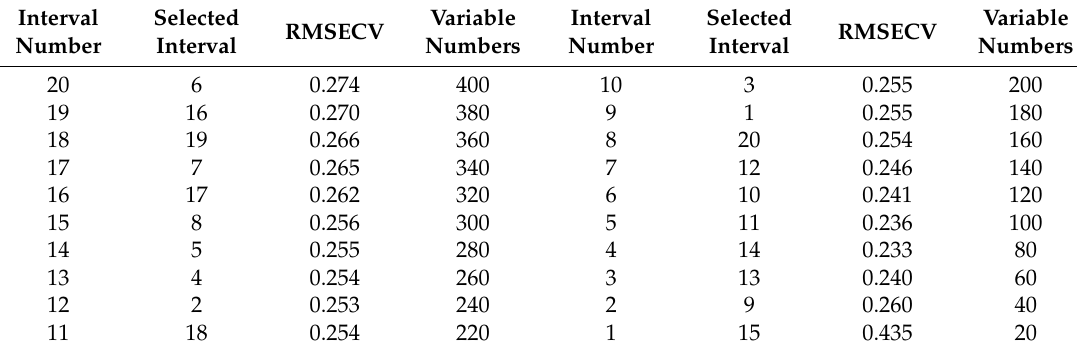
Figure 6. The sensitive waveband selection process ( a ) The characteristic variables selected by Competitive Adaptive Reweighted Sampling (CARS); ( b ) The number of PLS components and the corresponding Root Mean Square Error of Cross Validation (RMSECV) values while running BIPLS; ( c ) The characteristic intervals determined by BIPLS. Table 1. The processing results of characteristic variables by BIPLS.